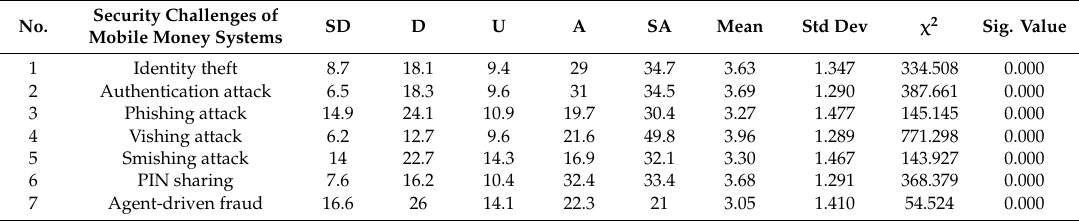
Table 4. Opinion of respondents regarding the security issues associated with mobile money systems.